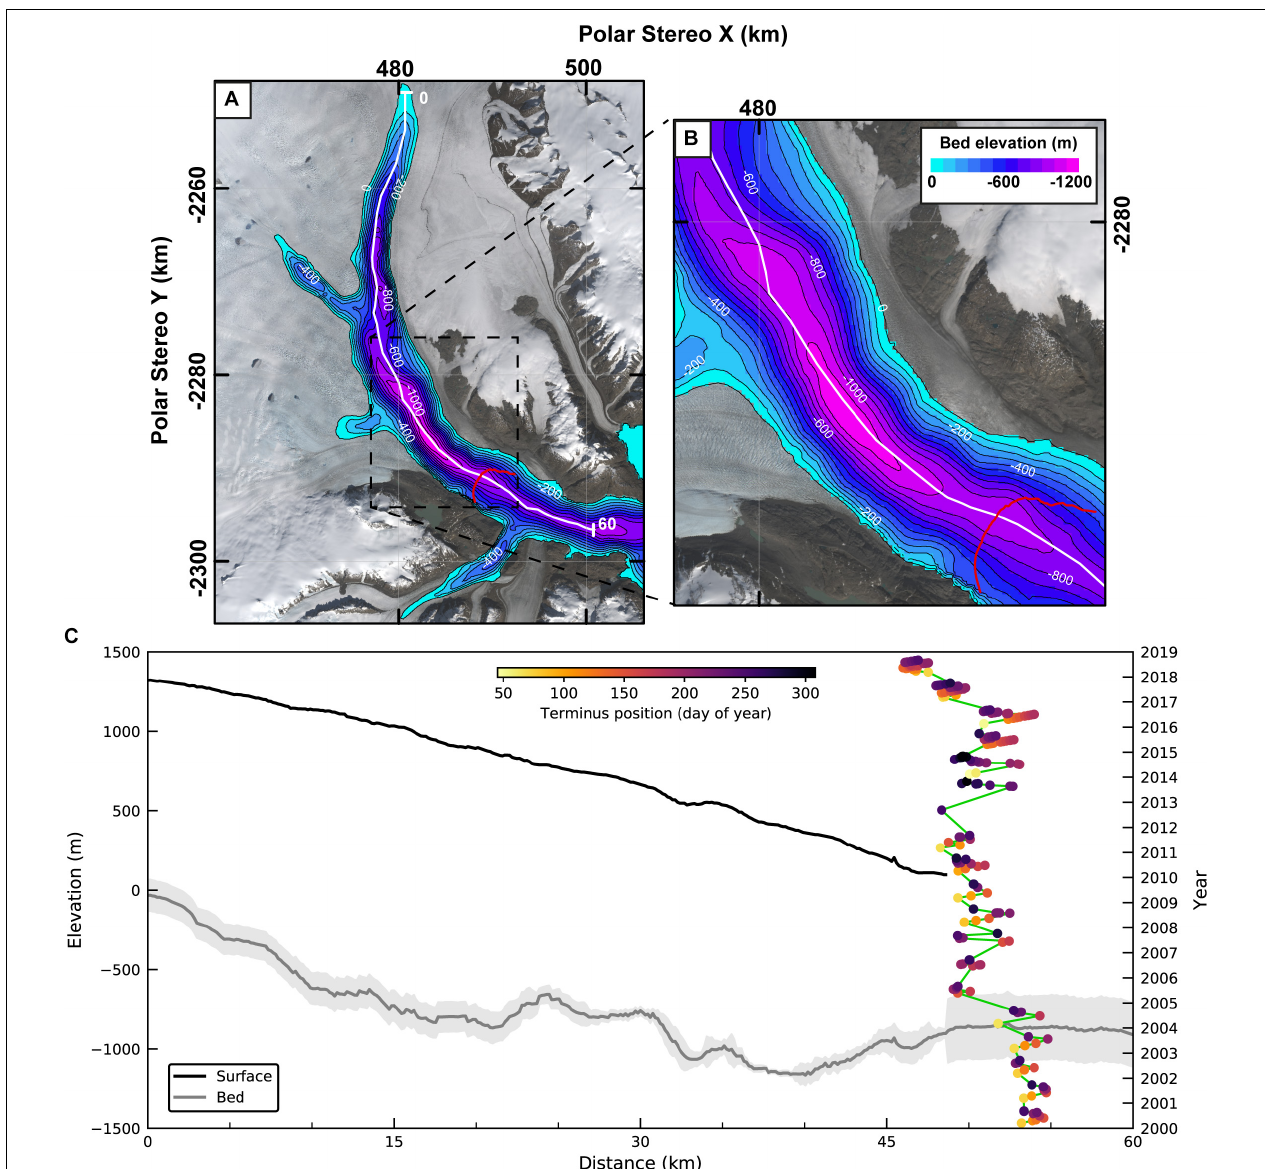
FIGURE 7 | Bed and surface profiles along the center line of Kangerlussuaq. (A) Bed elevation from BedMachine v3 (Morlighem et al., 2017a). White line indicates center line profile shown in (C) and red line demarcates most retreated ice front (16 May 2018). (B) Near-terminus view of (A) . (C) Bed and surface profiles overlain with terminus positions between 2000 and 2018. Terminus positions are colored by day of year. Gray line and shading correspond to the bed profile and spatially varying error obtained from BedMachine v3. Surface elevation data is obtained from the Greenland Ice Mapping Project (GIMP) surface digital elevation model provided as part of the BedMachine v3 distribution, and has a nominal date of 2007 (Howat et al., 2014). Background image in (A) and (B) as in Figure 1